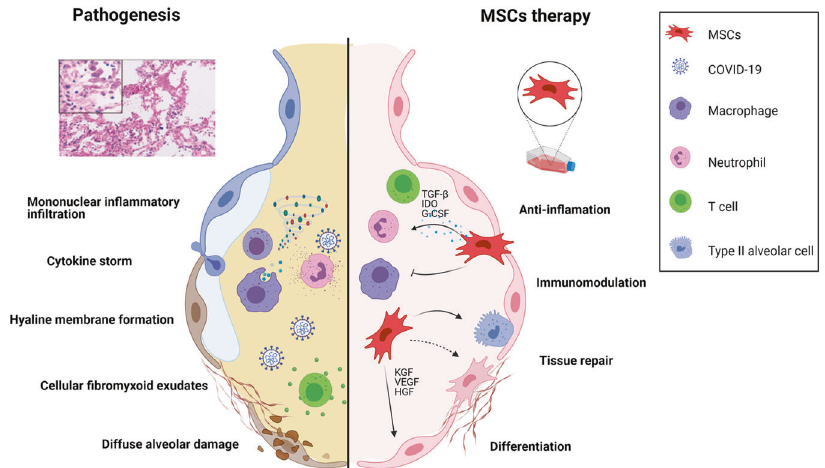
Fig. 1 Proposed mechanisms for MSC action in patients with severe COVID-19. At fi rst, SARS-CoV-2 primarily occupies the respiratory tract including the lung; the in fi ltration of immune cells (neutrophils, monocytes/macrophages, NK, CD4 + T, CD8 + T, Th17, and B cells) increases; then cytokine storms (including IFN- α , IL-1, IL-6 and TNF- α ) occur. Hyaline membrane formation, the release of cellular fi bromyxoid exudates, and pneumocyte desquamation are also observed. After stem-cell infusion, the number of in fi ltrated immune cells decreases signi fi cantly, and the damaged lung tissue is repaired. MSCs play a role in regeneration and immune regulation, but the detailed mechanisms underlying these effects remain to be fully